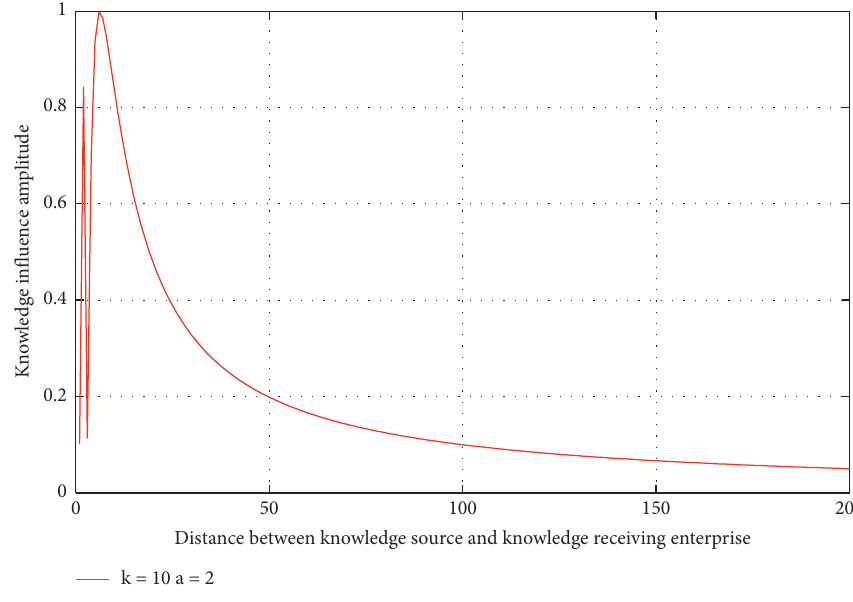
Figure 13: Distributions of the influence amplitude in the knowledge field when a � 2 and k � 2 , 5 , 10.